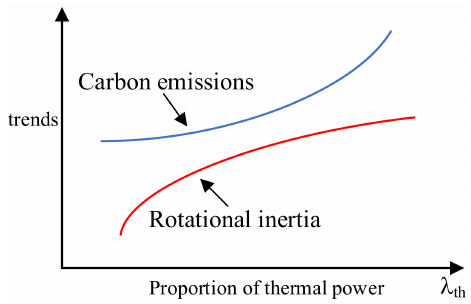
Figure 2. Trends in carbon emissions, rotational inertia, and proportion of thermal